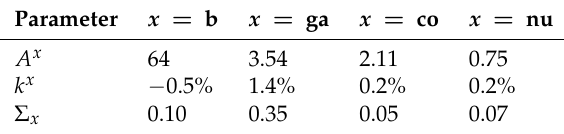
Table 1. Main economic assumptions. Source: Annual Energy Outlook 2019